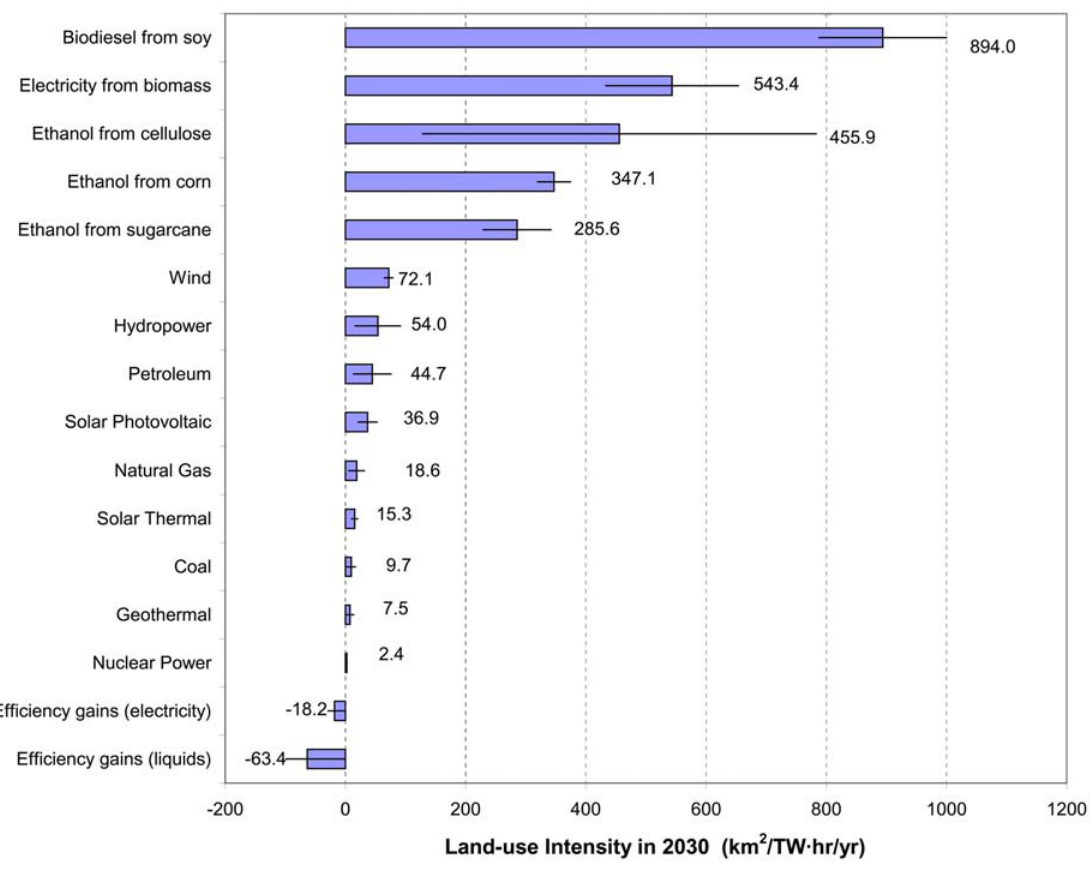
Figure 3. Land-use intensity for energy production/conservation techniques. Value shown is for 2030, as measured in km 2 of impacted area in 2030 per terawatt-hour produced/conserved in that year. Error bars show the most-compact and least-compact estimates of plausible current and future levels of land-use intensity. Numbers provided are the midpoint between the high and low estimates for different techniques. For liquid fuels, energy loss from internal combustion engines is not included in this calculation.